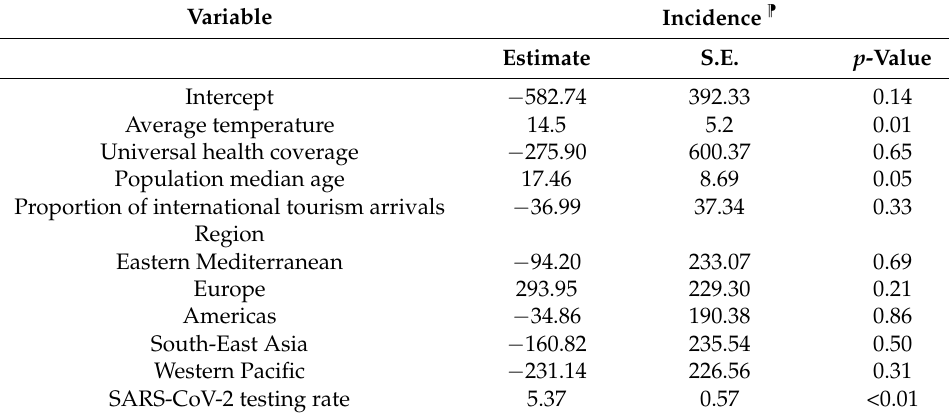
Figure 3. The nonlinear regression line of the average temperature and the ( a ) incidence rate and ( b ) mortality rate of Figure 1. Scatterplot showing the relationship between average annual temperature (°C) and ( a ) incidence (per million) SARS-CoV-2 in 36 OECD countries. and ( b ) mortality (per million) of SARS-CoV-2. Table 2. The parameter estimates of the multiple linear regression models. Table 1. Characteristics by the epidemic status of the study countries.